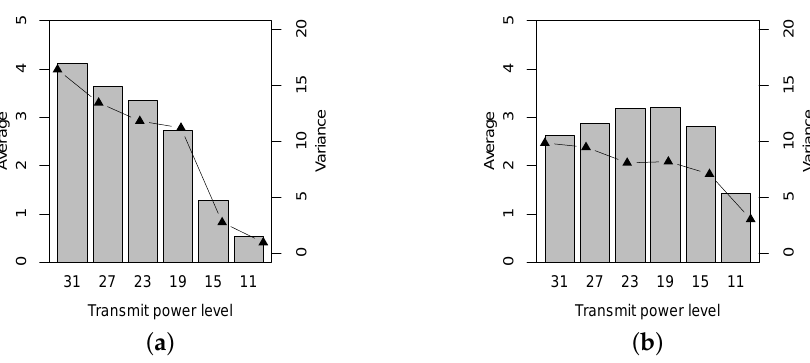
Figure 8. The asymmetry ( D rssi ) of RSSI under two different forest environments. ( a ) Bajia; ( b ) Campus.